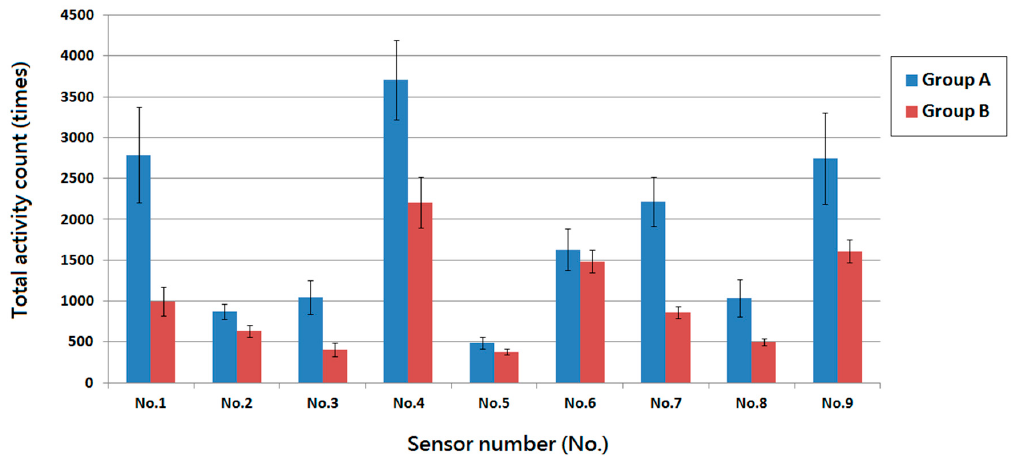
Figure 2. The postoperative one-week total activity counts of rabbits in the Animal behavior cage. Rabbits in group A showed higher total activity counts compared to that of rabbits in group B.